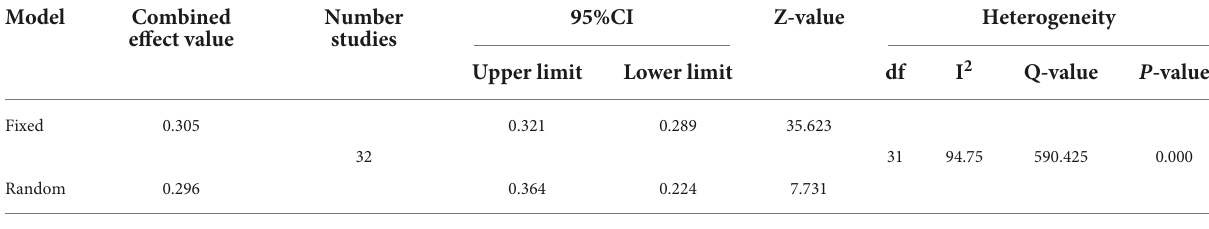
TABLE 3 Global effect hypothesis